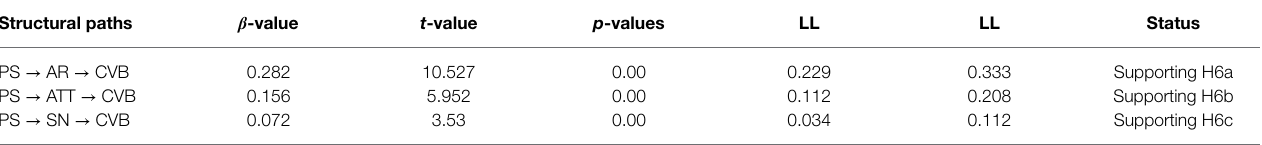
TABLE 7 | Mediation effect. Structural